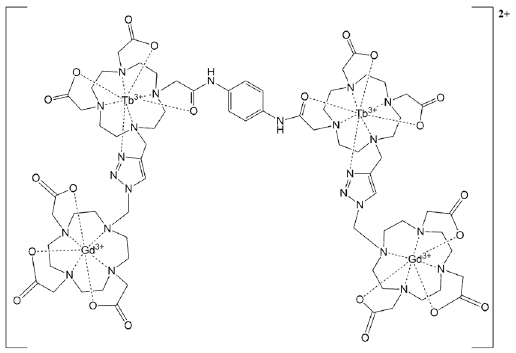
Figure 2. Open tetrameric heterolanthanide complex.